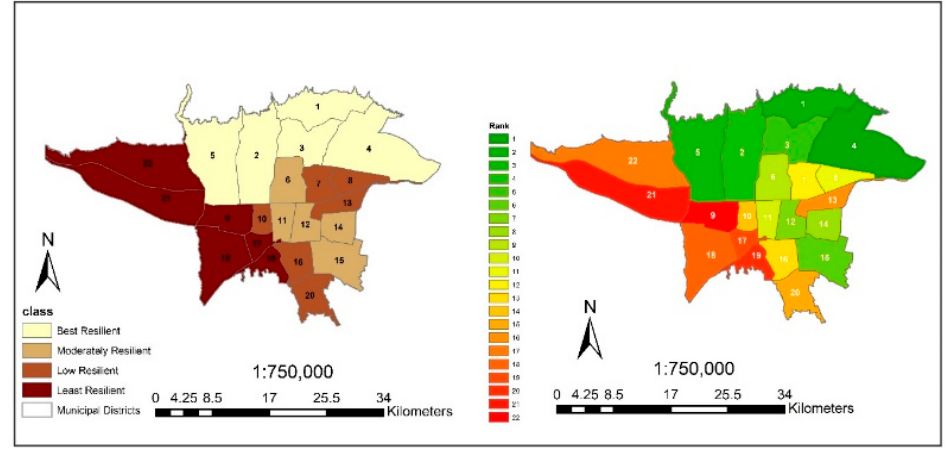
Figure 7. Tehran resilience to climate change: CRI classes (left) and municipal districts ranking (right).